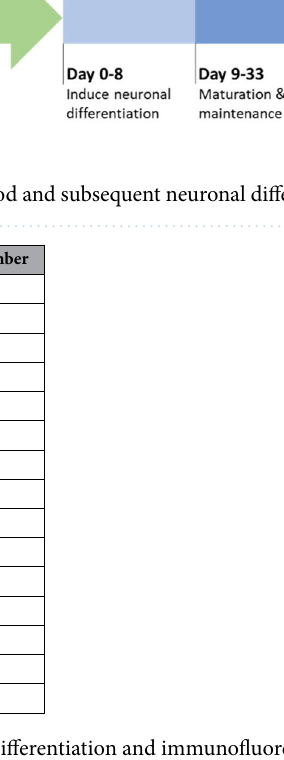
Table 1. Source information for the materials used in neuronal differentiation and